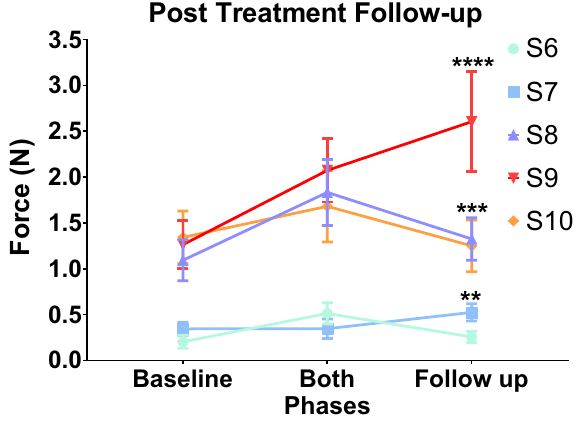
Figure 6. Follow-up MVC values when there was no stimulation or buspirone given to the patients in Group F 5 months after the last session of treatment. The MVC values of pre-treatment baseline (Baseline), the Both- phase (patients received both the stimulation and buspirone, Stim + Busp), and the follow-up washout sessions (Follow-up No Stim or Busp) were recorded from at least three different visits during each phase for subjects in Group F (**: P < 0.01 S7, ***: P < 0.05 S8, and ****: P < 0.0001 S9 when compared to the Baseline, detected by two-way ANOVA and Tukey’s test). The means and the standard deviation (SD) are